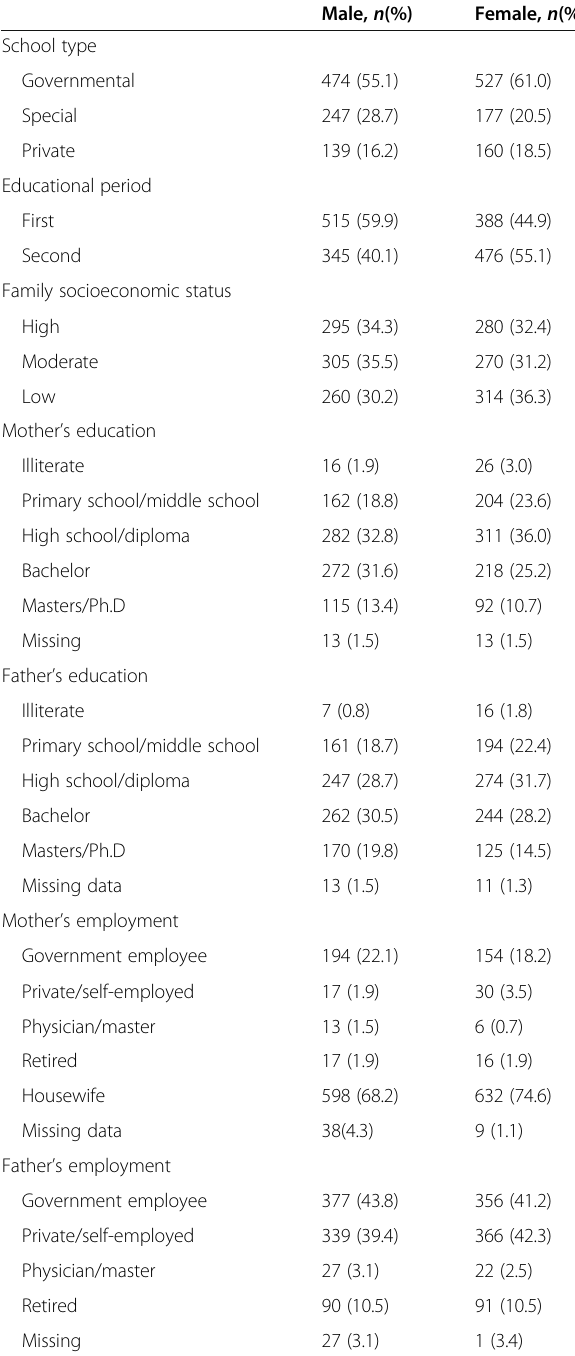
Table 1 The background characteristics of the adolescents in Qazvin City, Iran, in 2018 ( n =